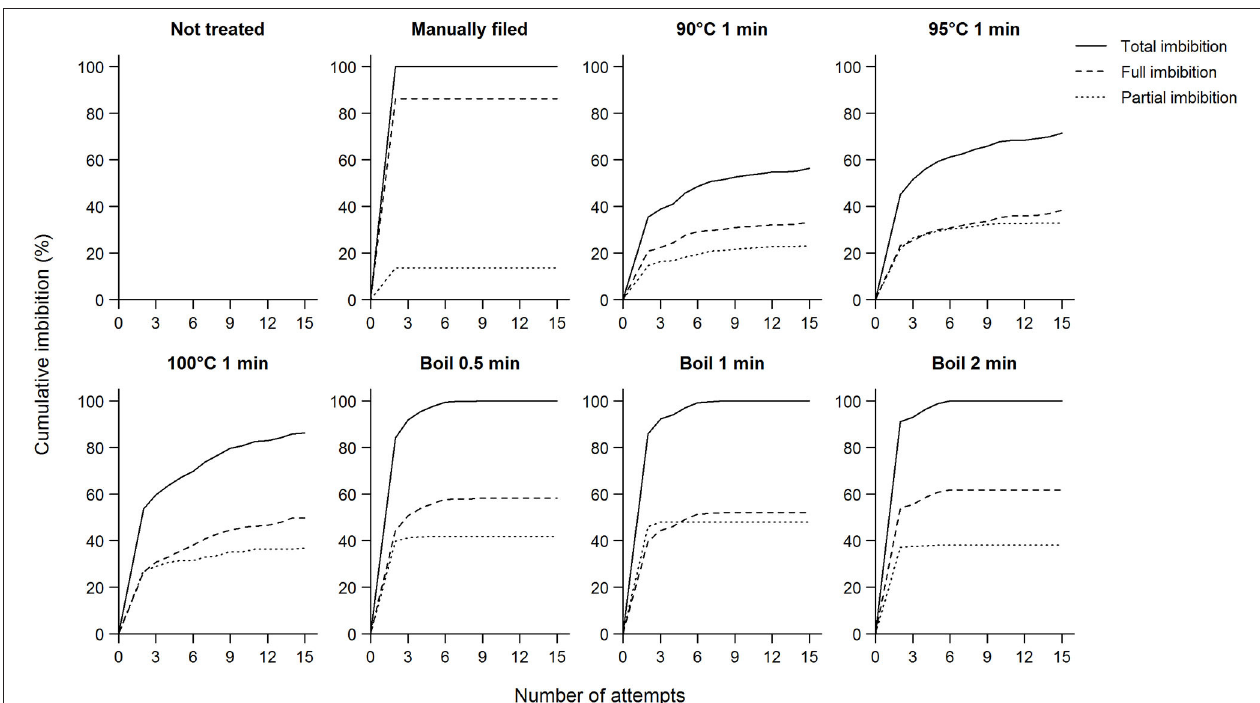
FIGURE 1 | Cumulative imbibition percentage of koa seeds and the number of attempts each treatment took for seeds to imbibe shown separately for whether seeds were fully imbibed or not. Total imbibition is the sum of full and partial imbibition ( Supplementary Figure 1 ). As for untreated seeds, we soaked seeds in room temperature water overnight without manual filing; only a small proportion of these seeds imbibed and the results are not visible in the subpanel. When seeds did not imbibe after 15 attempts, we manually filed them, which resulted in 100% imbibition (these results are excluded here). Data for each subpanel are for seeds from nine trees subjected to all scarification